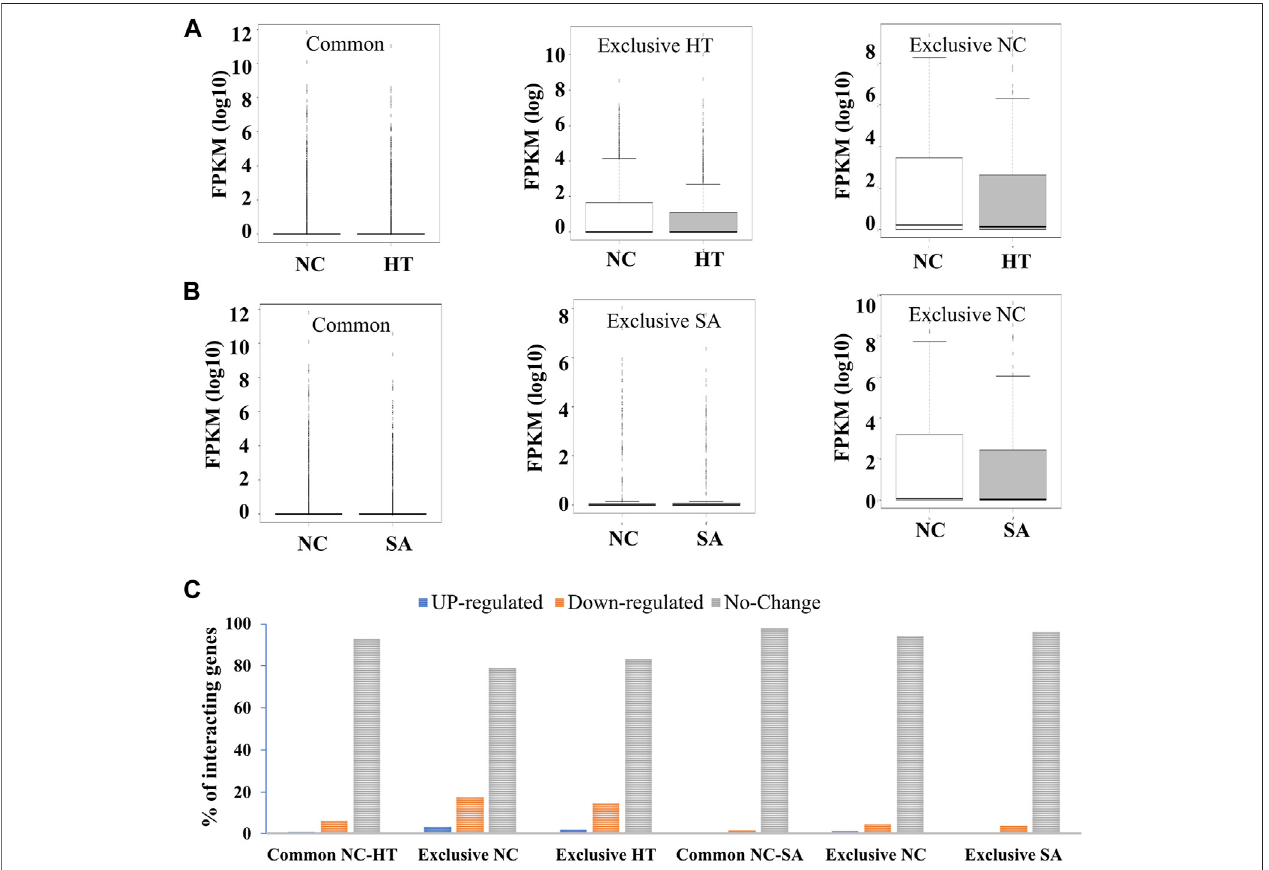
FIGURE 2 | Expression pro fi ling of common and uniquely interacting genes in control and stress conditions. Enrichment and depletion of interaction leads to common and unique interacting genes in HT as well as in SA libraries in comparison to the NC. These common and uniquely interacting genes in (A) NC vs. HT and (B) NC vs. SAdonot showany signi fi cantchange intheexpression pro fi le incontroland treated samples( p -value > 0.005)indicatingthatthese interactions may notdirectly regulate the expression of interacting genes. (C) Bar chart showing the percentage distribution of up-regulated, down-regulated, and unchanged expression of interacting genes in the common and exclusive interacting